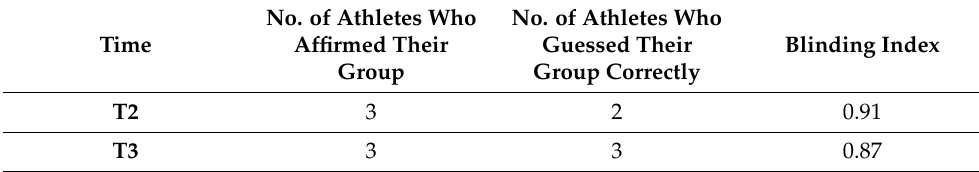
Table 9. The blinding index for the two study groups at T2 and